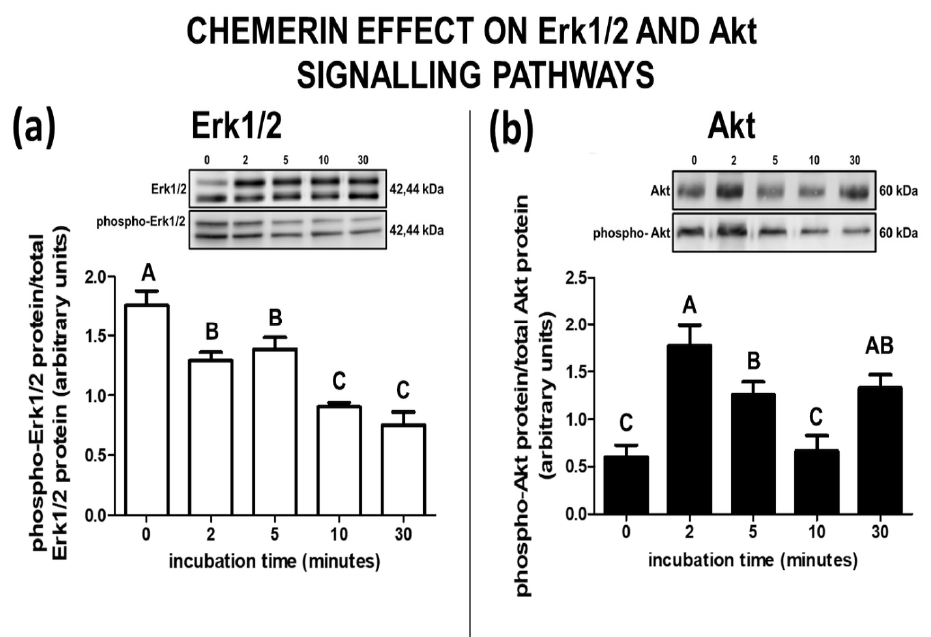
Figure 5. The effect of chemerin on the activation of Erk1/2 and Akt pathways. The influence of chemerin (200 ng/mL) on the activation of Erk1/2 ( a ) and Akt ( b ) signalling pathways in the in-vitro-incubated endometrial tissue explants collected from pigs on days 10 to 11 of the oestrous cycle. The total and phosphorylated Erk1/2 and Akt proteins’ abundances were evaluated using Western blot analysis. Upper panels—representative immunoblots, lower panels—densitometry analysis of phosphorylated target proteins’ relative content normalised with the total protein amounts. Data are presented as the mean ± standard error of the mean ( n = 5). Bars with different letters are significantly different at p < 0.05.